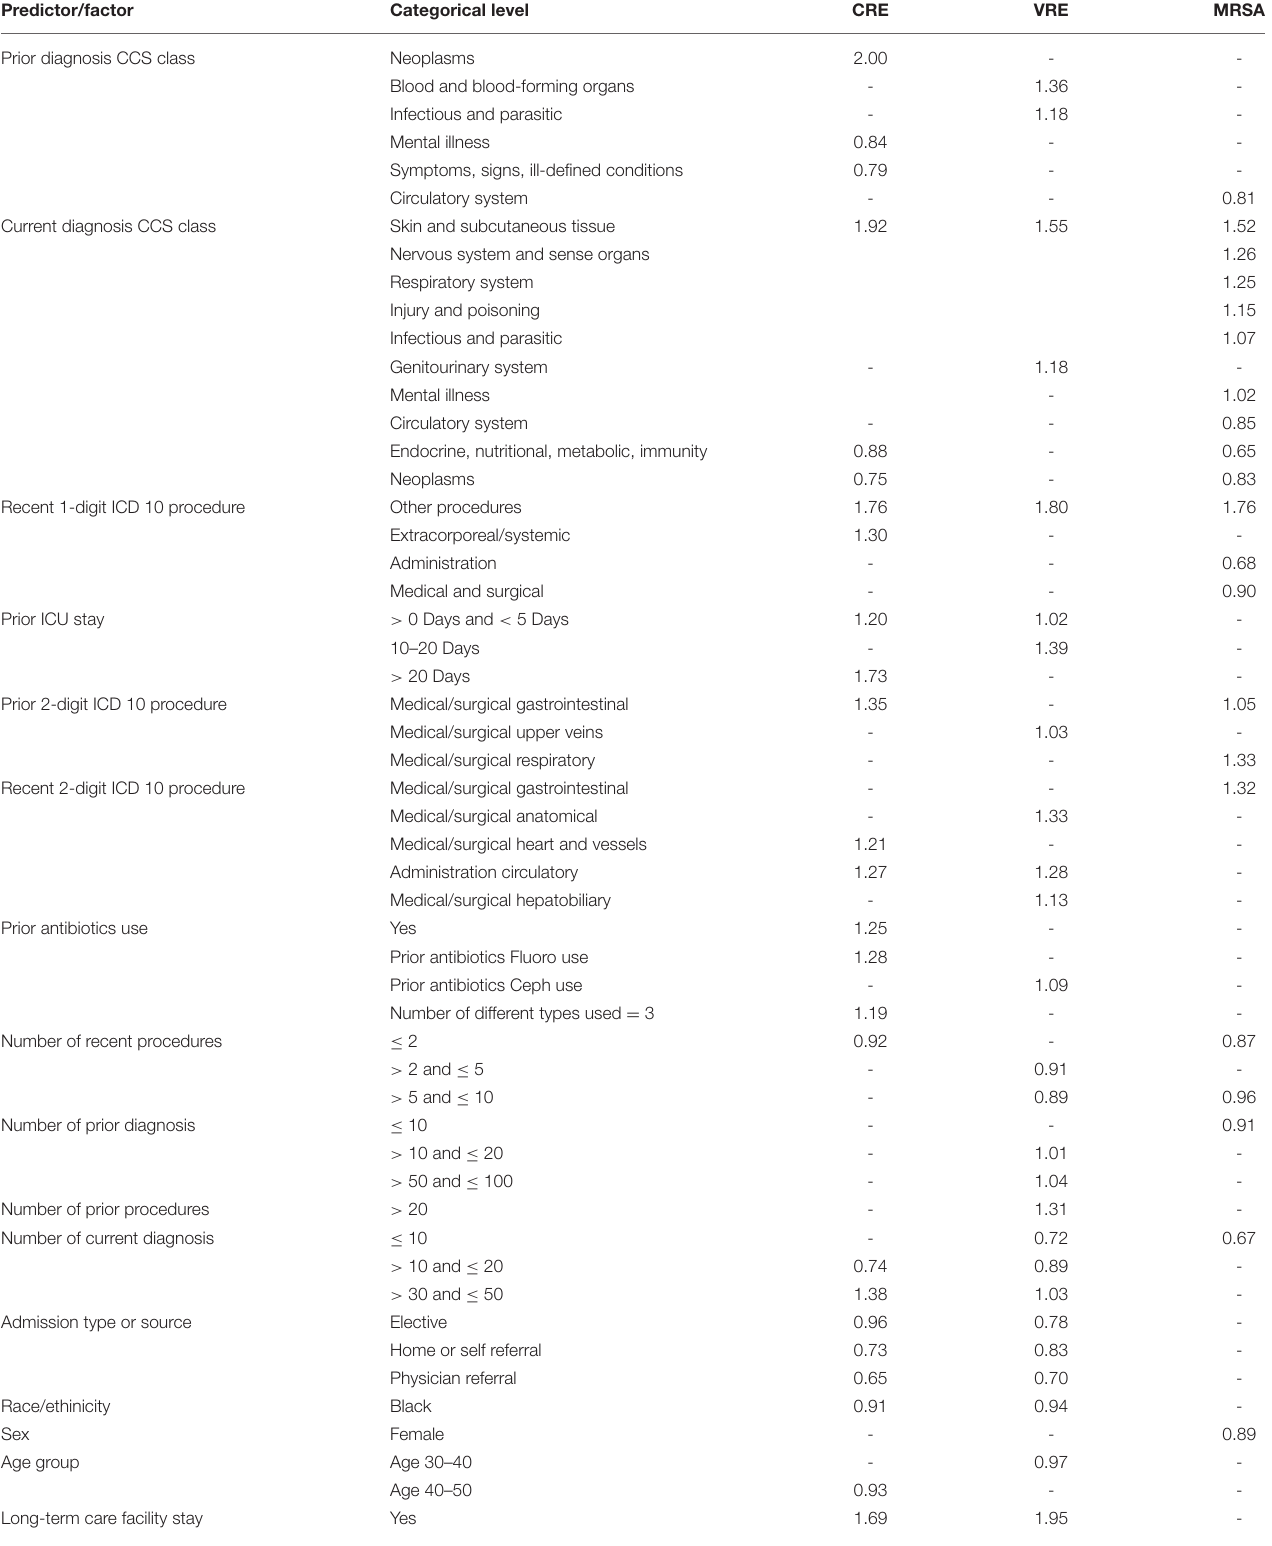
TABLE 7 | Predictors and coefficients (i.e., odds ratios) of the best performing logistic regression models.